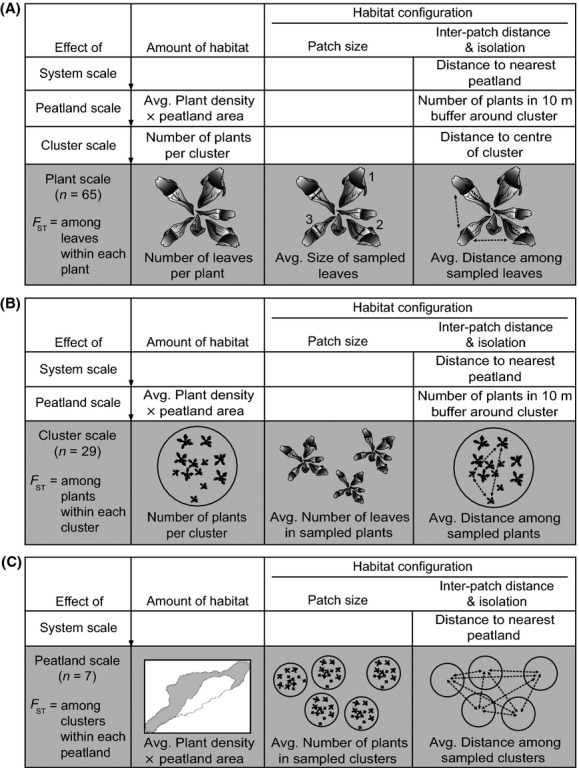
Summary of habitat amount and configuration measurements included in models at the (A) plant, (B) cluster, and (C) peatland scales.